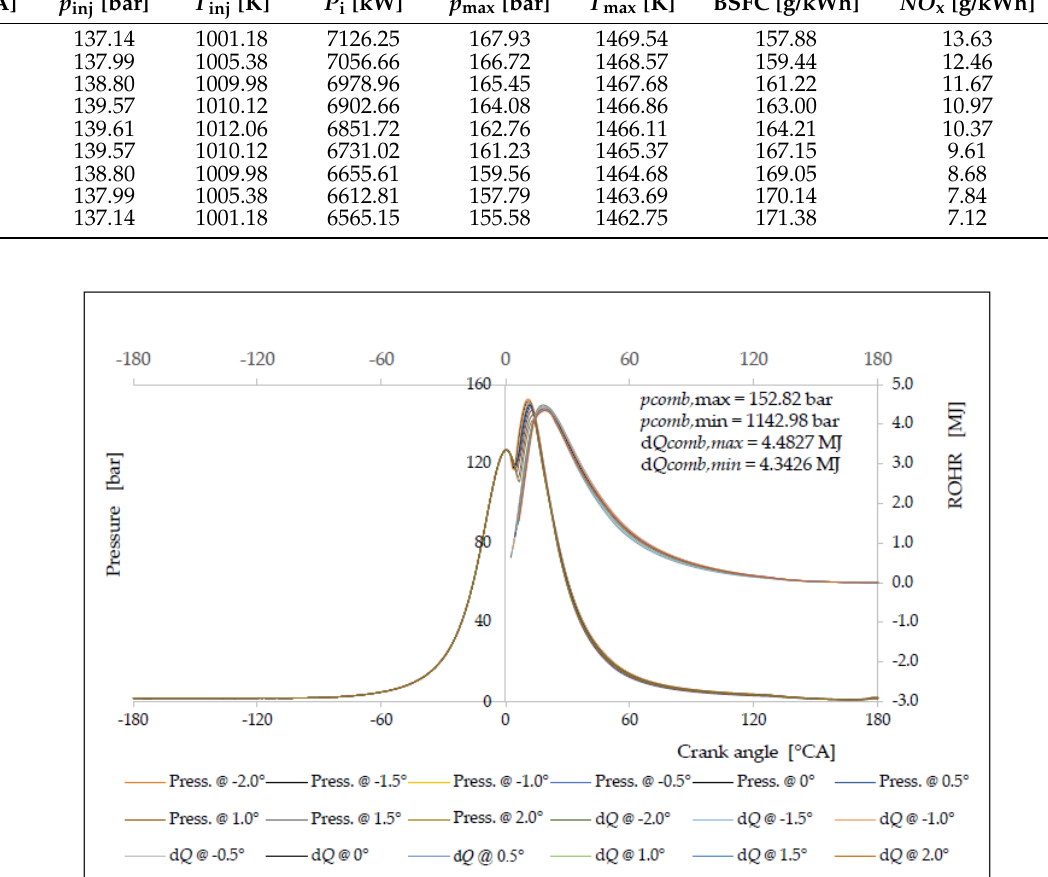
Figure 7. Pressure and heat release changes due injection timing changes at 50% MCR [22].